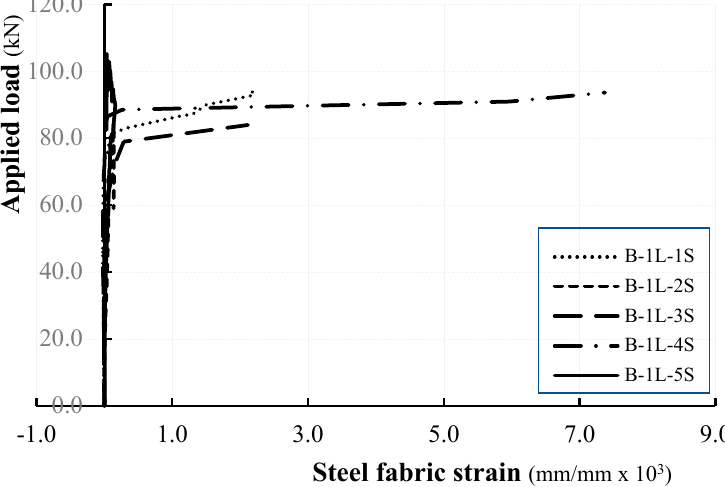
Figure 15. Load–steel fabric strain curves for beams strengthened with single-layer SRG strips.